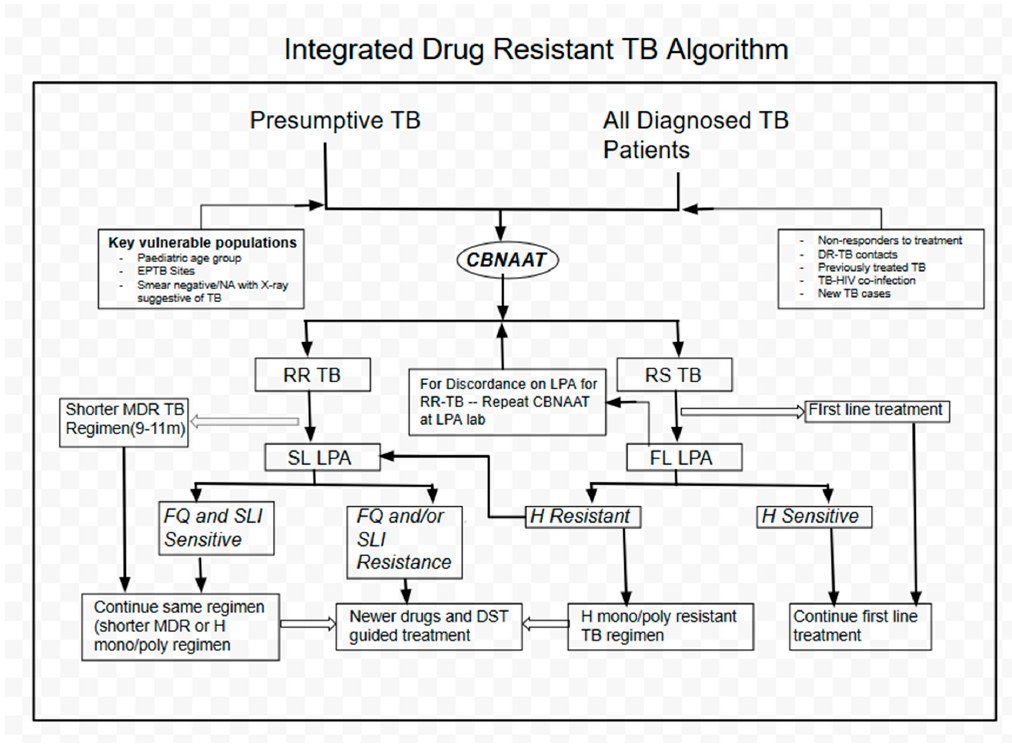
Figure 1. Diagnostic algorithm of drug-resistant tuberculosis as per PMDT India 2017. RR-TB, rifampicin-resistant tuberculosis; RS-TB, rifampicin-sensitive tuberculosis. SL-LPA, second line,